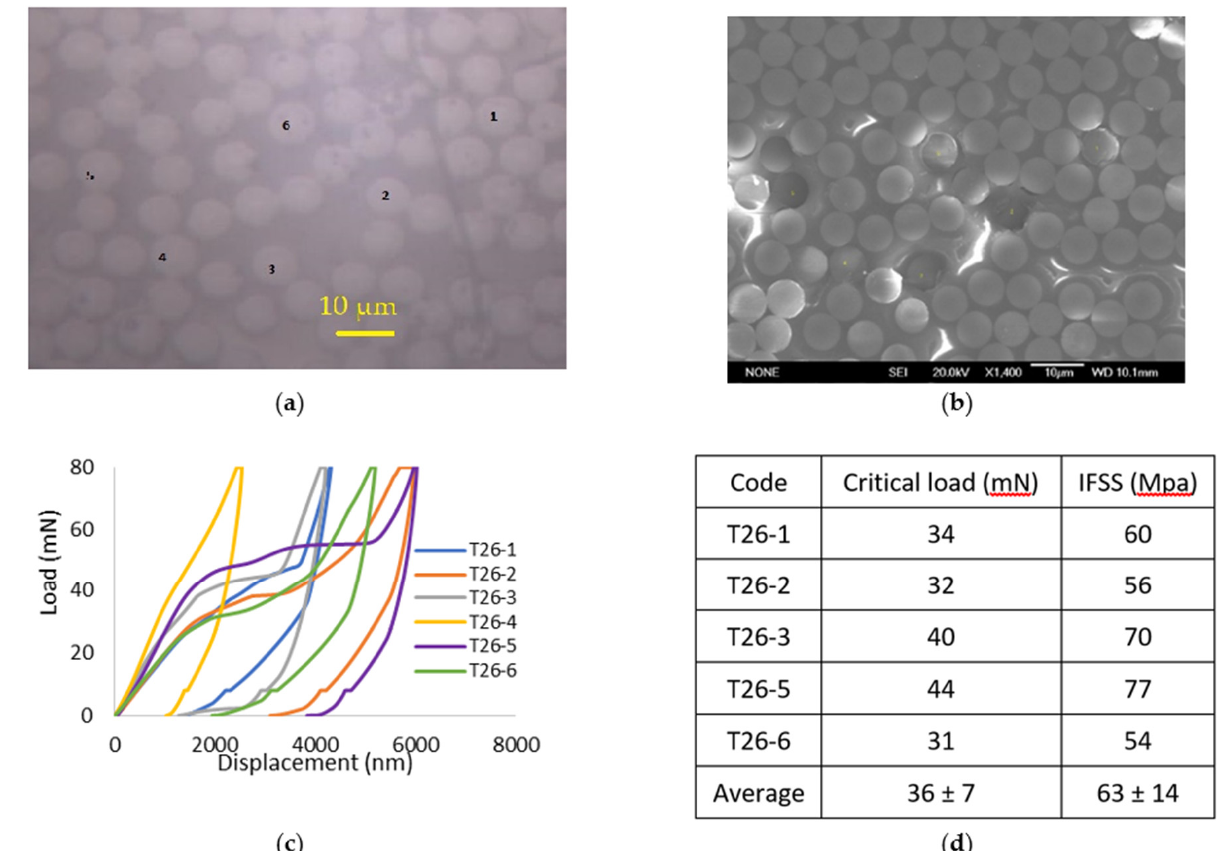
Figure 9. The carbon fibres in a 26 µ m (T26) thick T700-31E specimen ( a ) before and ( b ) after push-out test, ( c ) load vs. displacement curves, and ( d ) the critical load and the relevant IFSS .